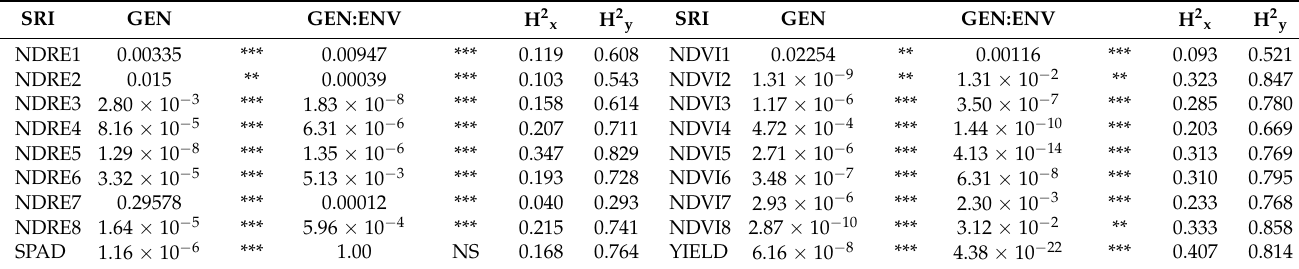
Table 7. p -Values for Likelihood Ratio Test of the analyzed SRIs for genotype and genotype-vs- environment random effects, broad-sense heritability on a plot basis over environments (H 2 x), and broad-sense heritability on an entry mean basis over the test environments (H 2 y).